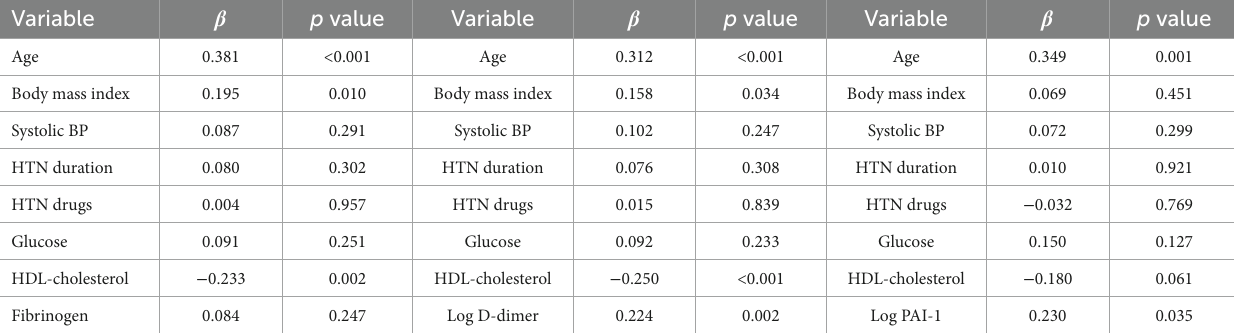
TABLE 5 Multivariate regression models with Augmentation Index (AIx) as the dependent variable and separate inclusion of coagulation variables. Variable